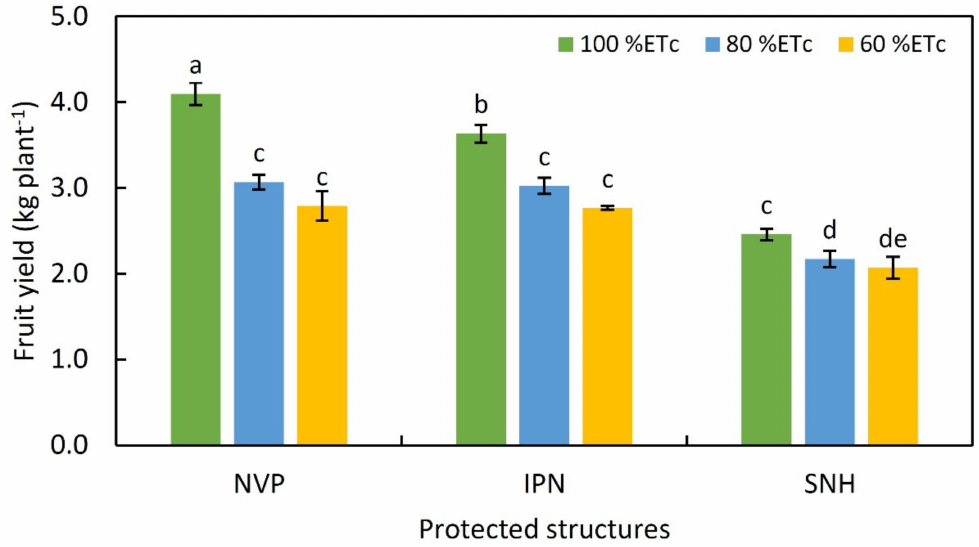
Figure 2. Total fruit yield (kg plant − 1 ) in protected environment structures at different levels of irrigation levels. Mean values followed by the same letter are not significantly different at p ≤ 0.05 according to DMRT. NVP, Naturally ventilated polyhouse; IPN, Insect-proof net house; and SNH, Shade net house.